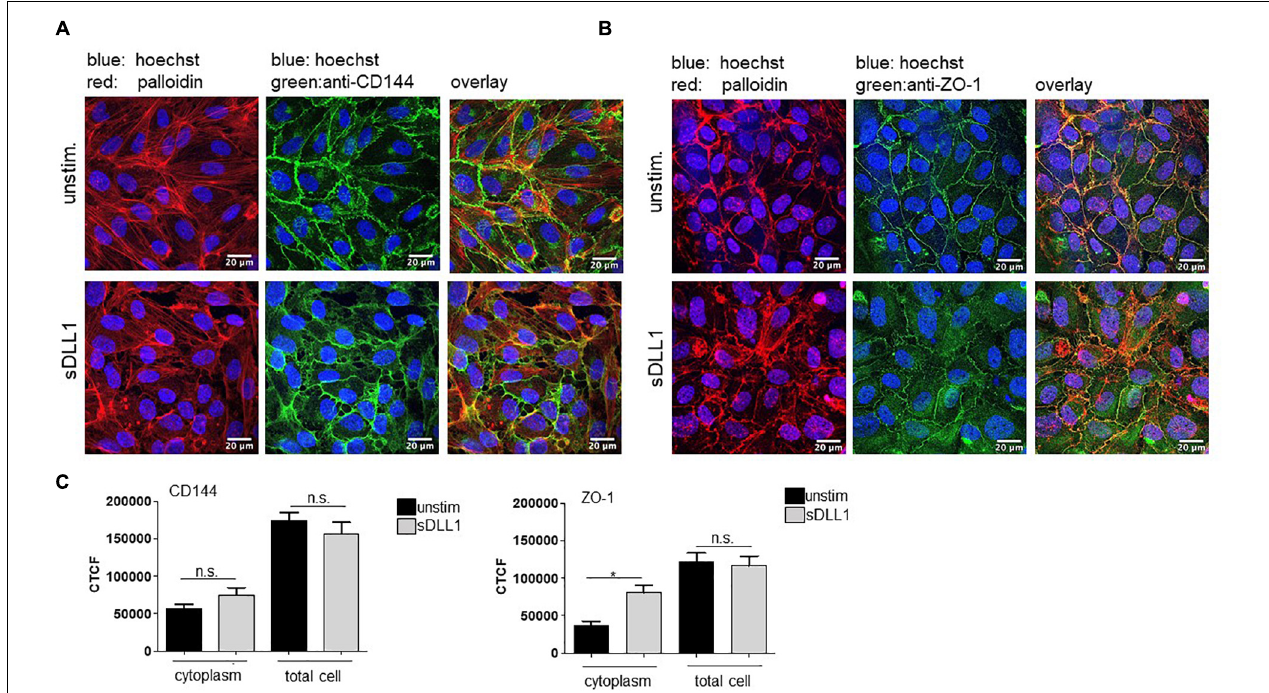
FIGURE 4 | sDLL1 promotes loosening of HUVEC structure. Coculture was stimulated with sDLL1 (5 µ g/ml) for 3 h. Blood cells were removed via rinsing with PBS. HUVECs were fixed on membranes with PBS/PFA and permeabilized with PBS/Triton-X. Cells were stained with anti-CD144 against VE-cadherin and anti-mouse-cy5 [ (A) , shown in green], or anti-Zo-1 and anti-rabbit-DyLight488 [ (B) , shown in green], phalloidin-tetramethylrhodamine B Isothiocyanat against F-actin (shown in red), and Hoechst-33342 against DNA (shown in blue). Membranes were cut and mounted on microscopic slides. Images were taken using a Leica SP8 confocal microscope, an inverted microscope, and LAS X software. Images were analyzed and processed in Fiji/ImageJ. (C) For quantification of Ve-cadherin and ZO-1, microscopic images were converted into black and white, and integrated density was measured from total cells and the cytoplasm of cells. Quantifications depict corrected total fluorescence (CTCF). n.s. = not significant. The experiment was repeated three times with comparable